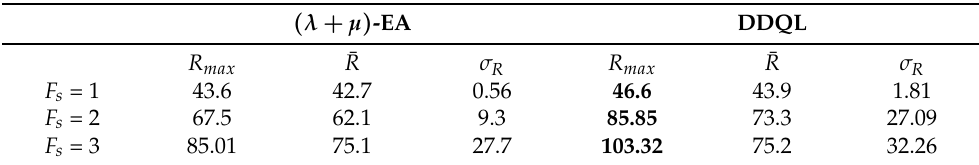
Table 8. Experiments results for multi-agent case in EA and DDQL algorithms when optimizing with N = × 2 for 150 generations in EA and 1500 episodes in DDQL.